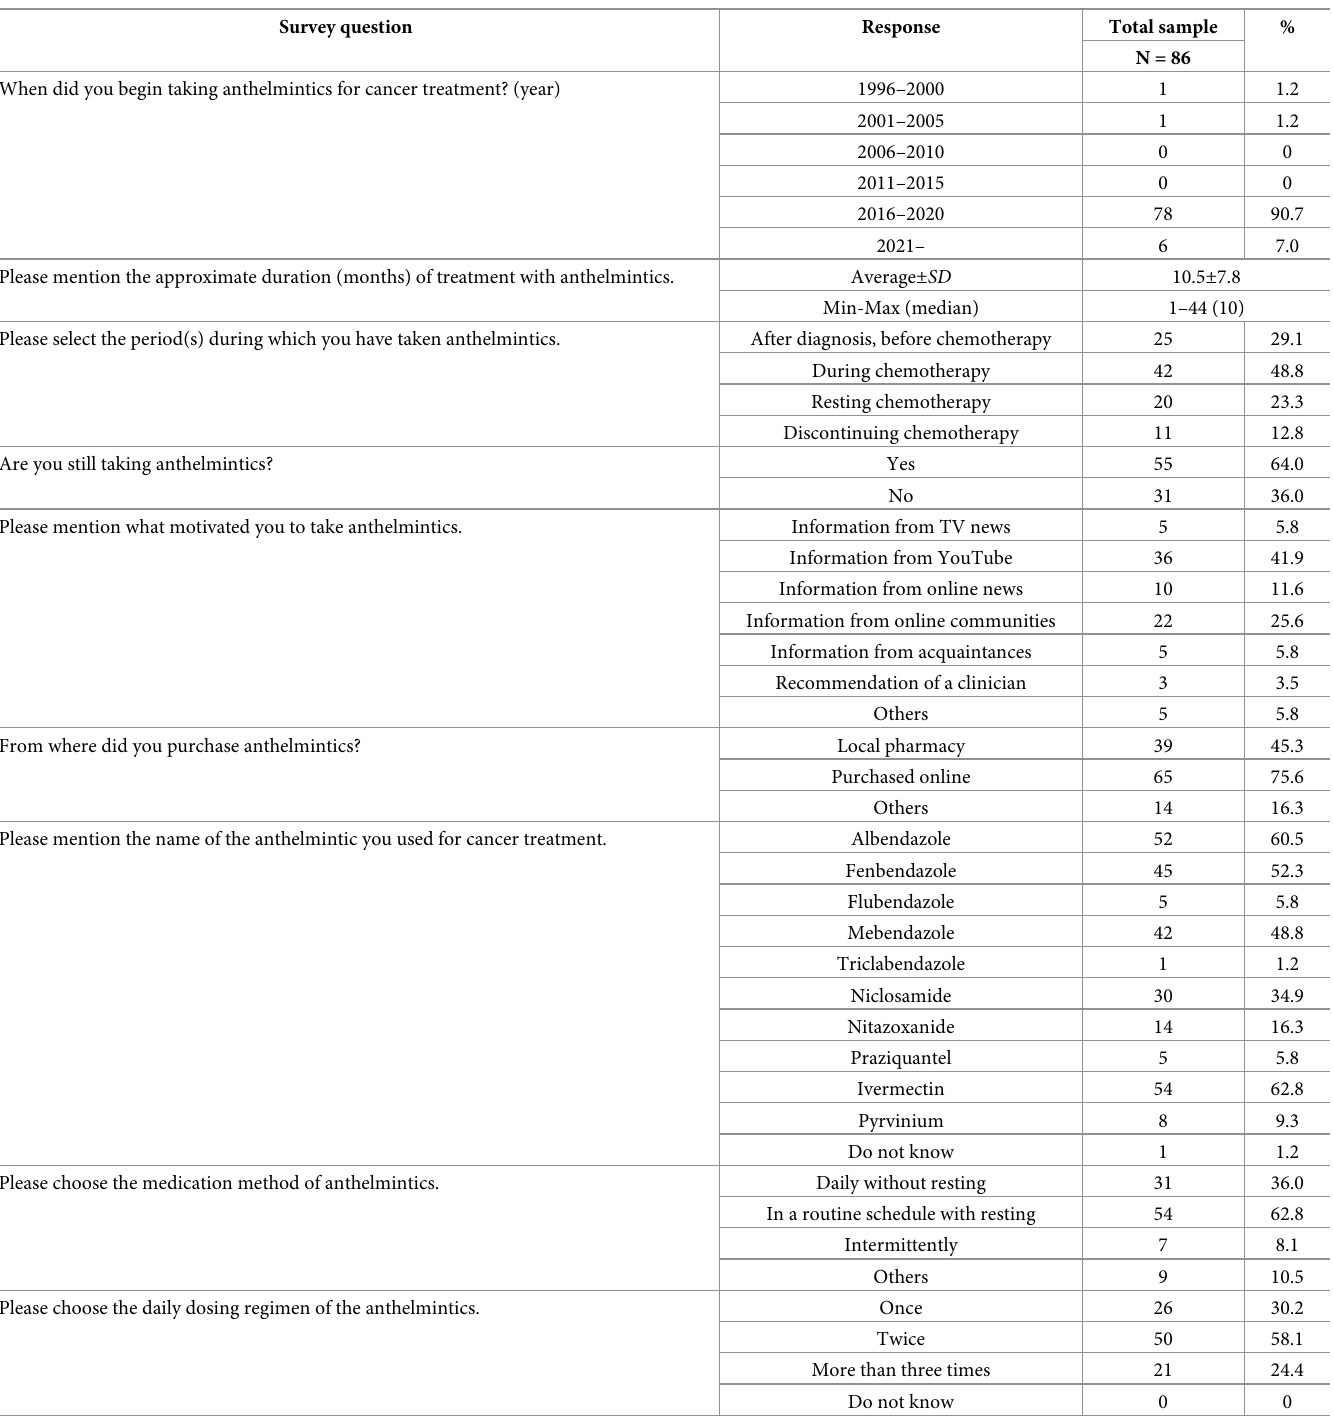
Table 2. Details of anthelmintic use for cancer